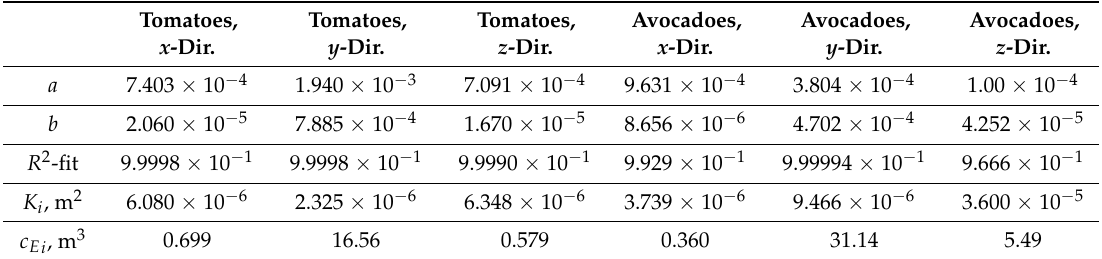
Table 1. Curve fits to the REV pressure drop data and calculated values of K i and c Ei .